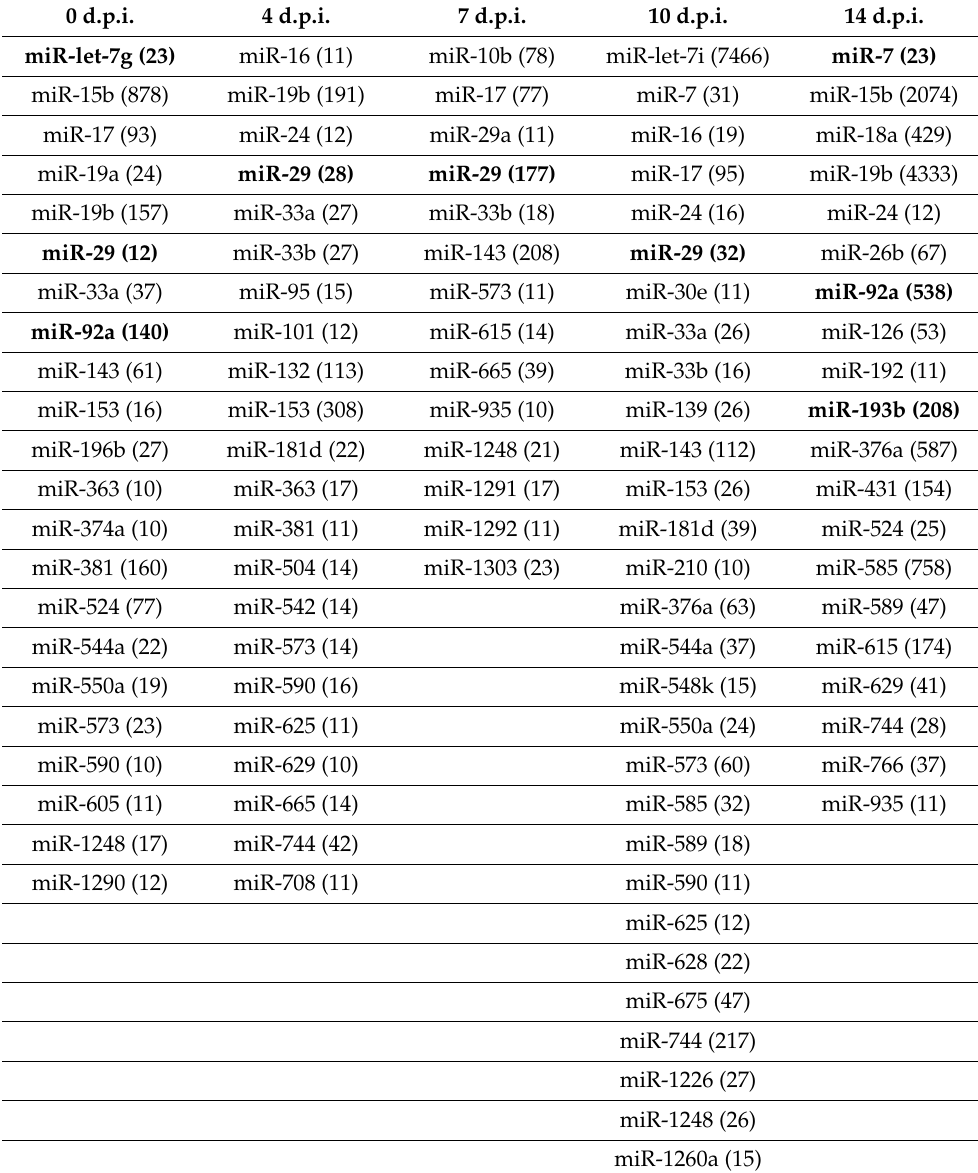
Table 4. Most up-regulated miRNAs (>10-fold) in human herpesvirus 6A (HHV-6A) infected fibrob- lasts at 0, 4, 7, 10 and 14 days post-infection (d.p.i.) §. 0